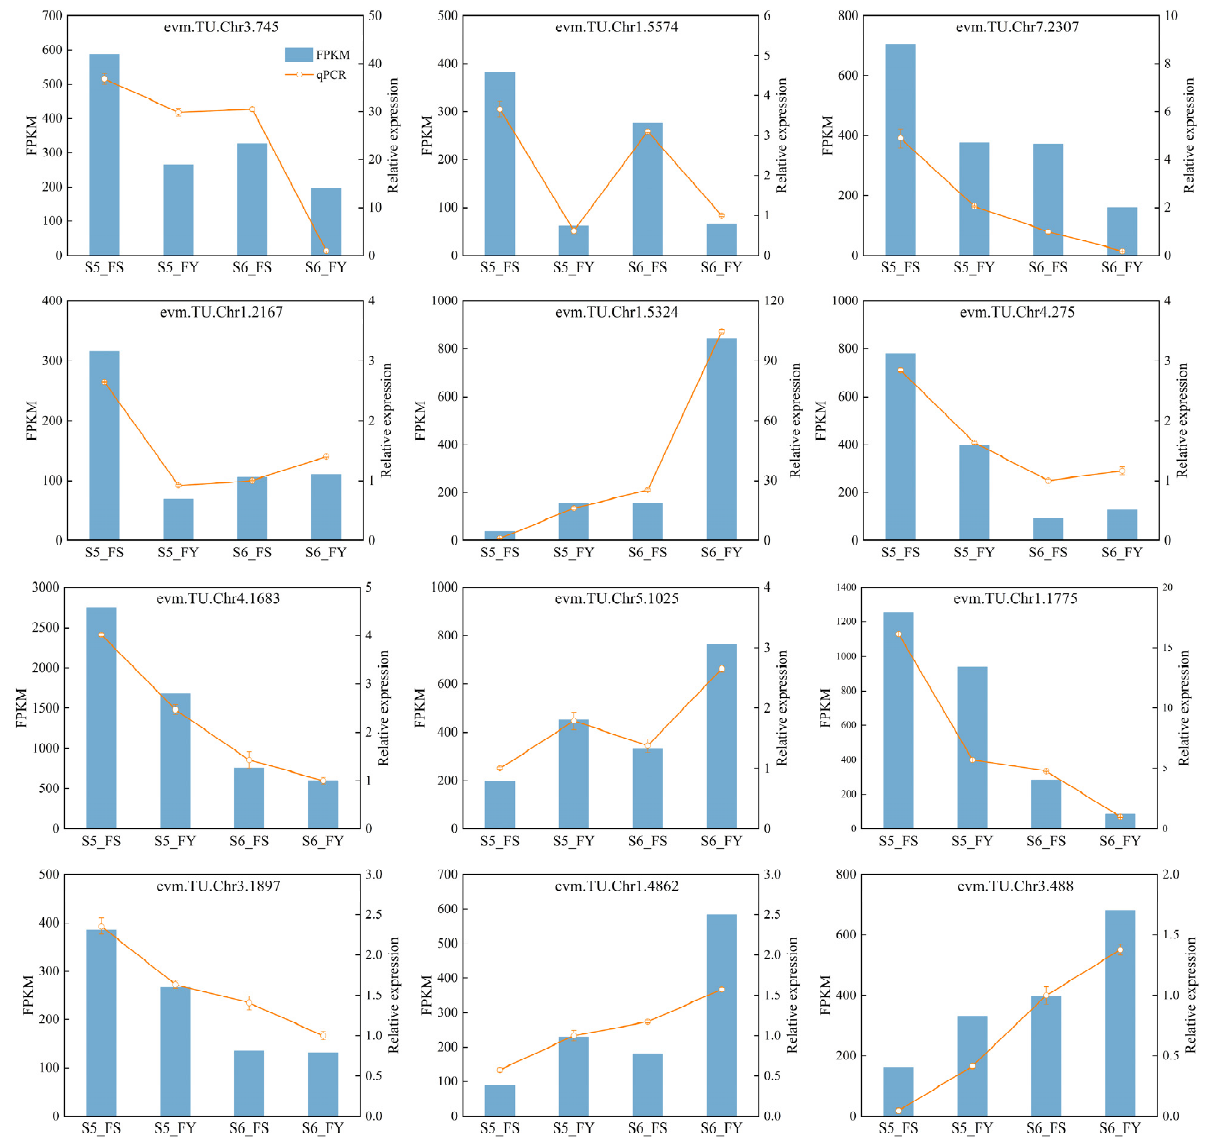
Figure 8. Real-time quantitative PCR validation profiles of twelve randomly selected genes from FS and FY fruits. The vertical bar indicates the standard error. The Y-axis on the left is the gene FPKM from RNA-seq (blue histogram). The y-axis on the right indicates the gene relative expression levels from the corresponding qRT-PCR analysis (orange line).